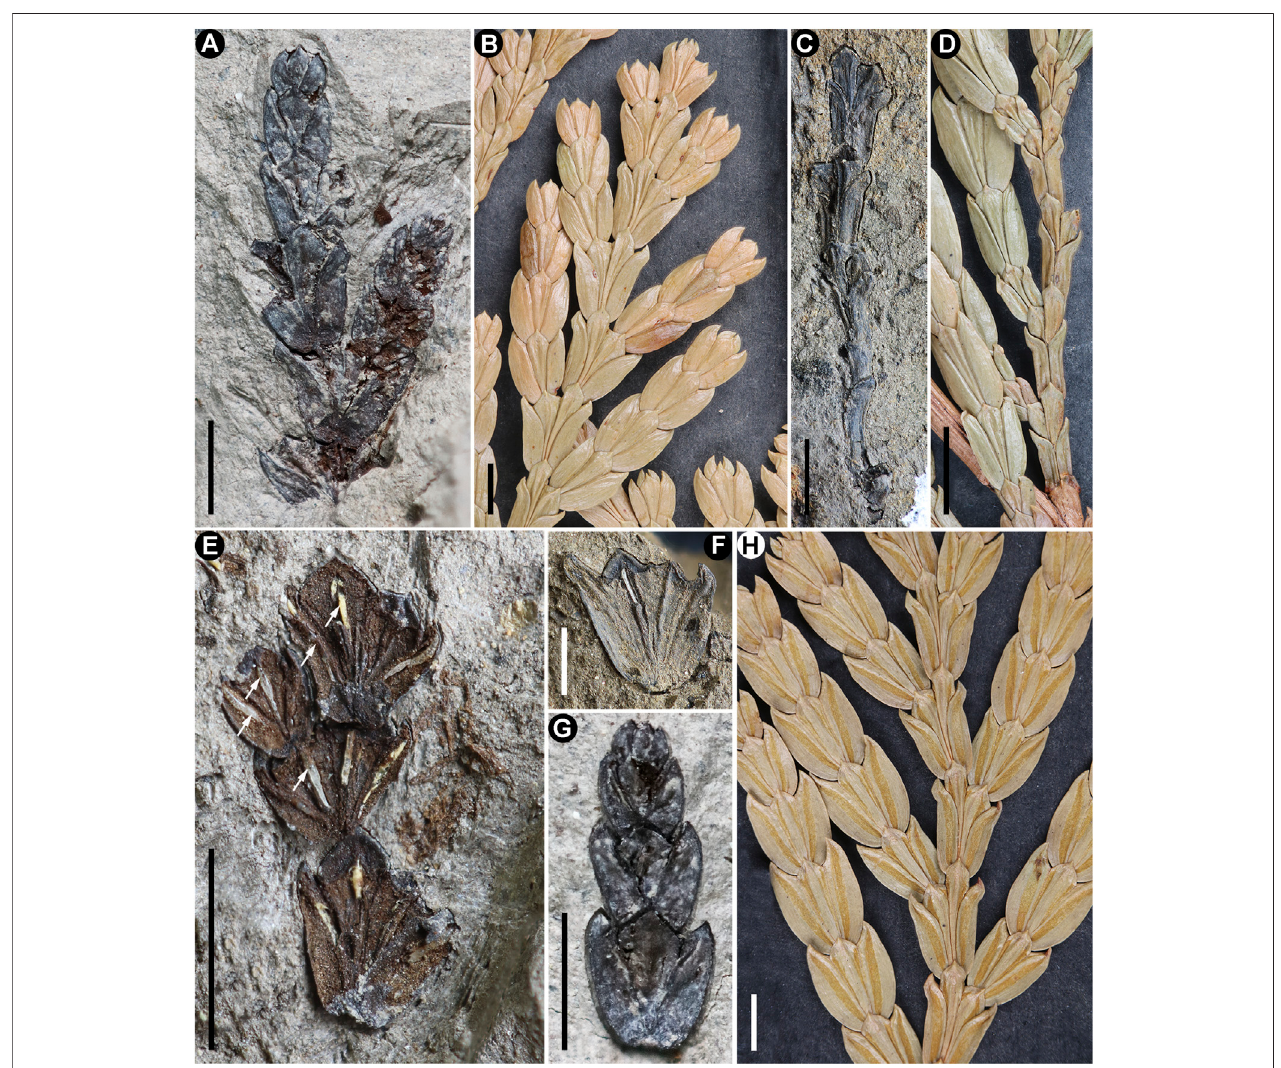
FIGURE 3 | Foliage of Fokienia tianpingensis sp. nov. (A, C, E – G) and extant species F. hodginsii (Dunn) Henry et Thomas (B, D, H) . (A) Branchlets of two orders, showing the alternate branching pattern, holotype TX-2 – 1. (B) Similar ultimate branchlets of extant species. (C) Incompletely preserved shoot bearing penultimate branchlets,TX-38 – 1. (D) Similar shootofextant specieswithpenultimate branchlets. (E) Longitudinalsectionofpenultimate branchletshowingoneresincanalpereach leaf (arrows), TX-70A-1. (F) Compound cladode-like segment of the branchlet junction showing resin canals, TX-35 – 1. (G) Ultimate shoot, TX-2 – 2. (H) Lower side of shoot showing stomatal bands. Scale bars for (A, G) (cid:1) 2 mm, (B, C, E, H) (cid:1) 3 mm, (D) (cid:1) 5 mm (F) (cid:1) 1 mm.